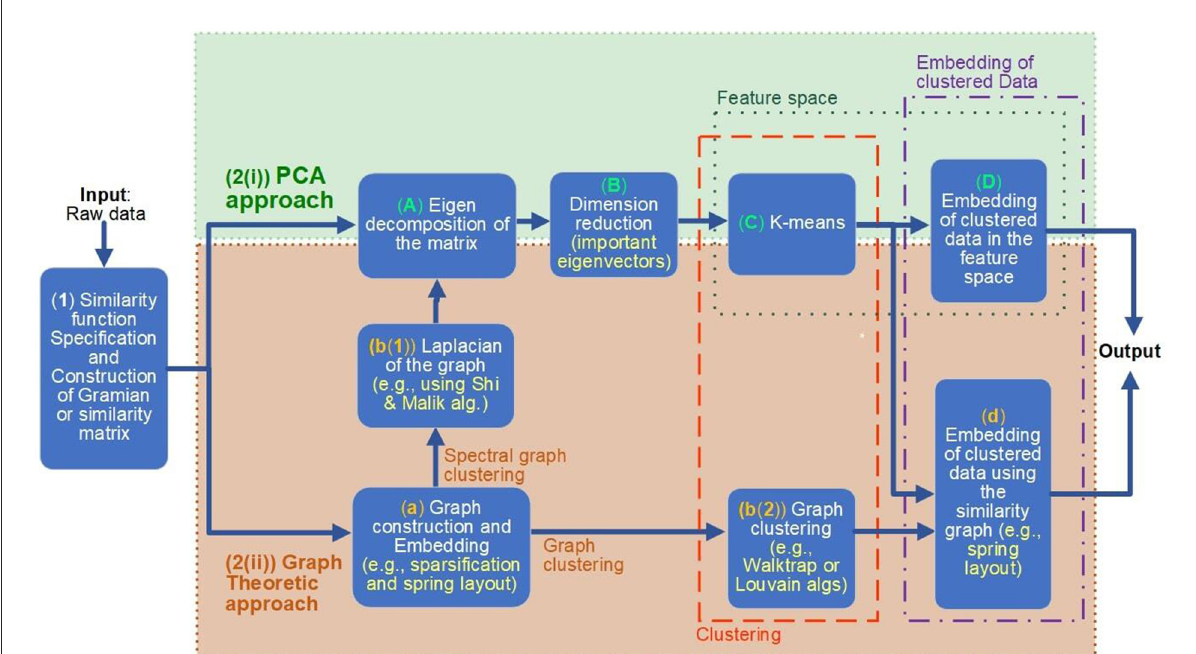
FIGURE2 The unified framework for modeling, clustering, embedding, and feature extraction of complex systems. Various numbered boxes indicate the steps of the analysis. After the first step, where the appropriate similarity function is chosen and applied [box (1) of the figure], the framework allows two alternative computational paths to be followed; both of them allow a clustering (orange dotted surrounding box) and then embedding of the (clustered) data (purple dotted surrounding box): the principal component analysis (PCA) approach [indicated with green dotted surrounding box, numbered as 2(i)] or the graph theoretic approach [indicated with brown dotted surrounding box, numbered as 2(ii)]. Following the PCA approach computational path, the Gramian matrix is mapped to the Eigen space (i.e., the Feature space), where clustering is performed [boxes (A–C) of the figure]. On the other hand, following the graph theoretic computational path, the clustering is performed on the constructed similarity graph [computed in step (a)], either directly on the graph [box b(2)], following the graph clustering option (indicated with corresponding labeled arrow) or indirectly on the eigen space of the Laplacian of the graph, following box [b(2) and then (A–C) ]. Finally, the clustered data are embedded either in the feature space [step (D) ], if the PCA approach is followed, or through various graph embeddings (including also the eigen space embedding), in the case where the graph theoretic approach is